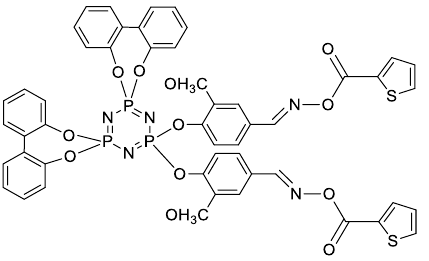
Figure 16. Molecular structure of compound 21d [61].